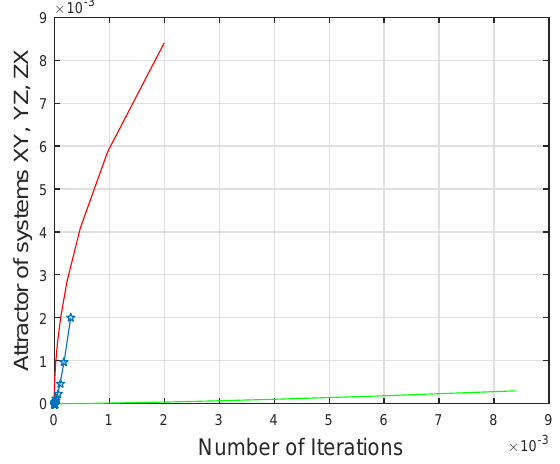
Figure 21. Attractors of system ( 3 ) x n y n (shown in blue line) y n z n (shown in green line) z n y n (shown in red line) in 2D when α = 0.5, β = 1.7, γ = 1.6, δ = 0.3, ζ = 0.7, η = 1.6, µ = 2.7, ε = 0.6, υ = 0.8, ρ = 1.11, σ = 1.11, ω = 0.2. with initial conditions x 0 = 0.002, y 0 = 0.0084 and z 0 =